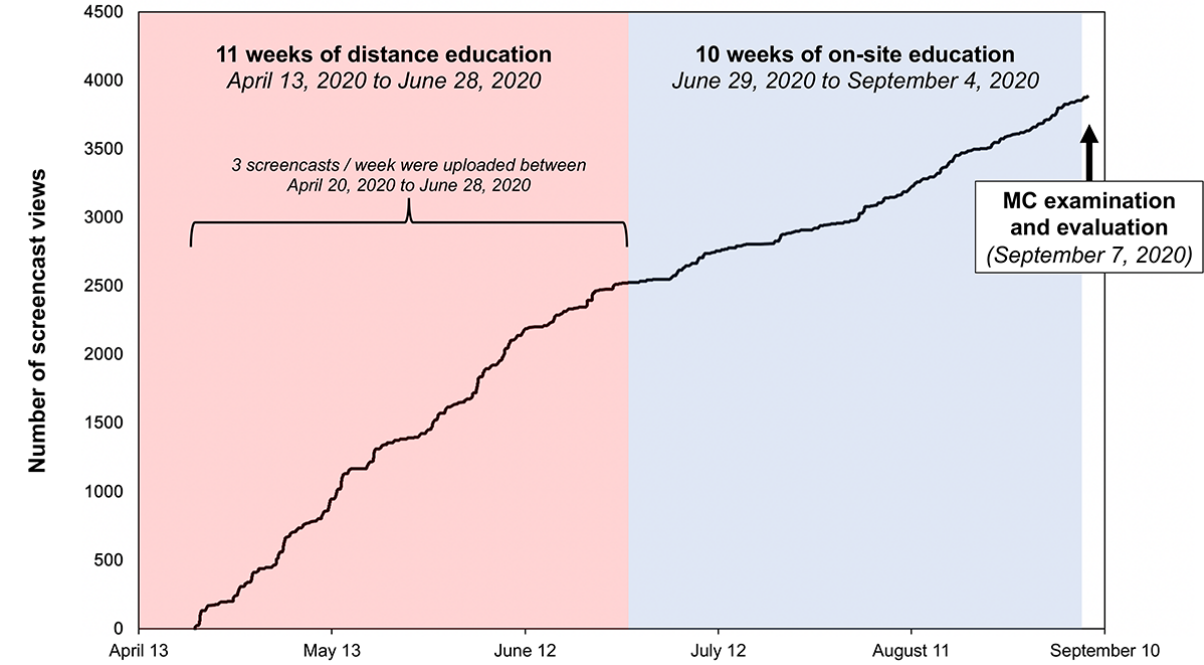
Figure 2. Number of screencasts views over time. Time spans of distance education (theoretical knowledge) and on-site education of physical skills are marked by different colors. All screencasts were uploaded during the distance-education phase. The final examination and evaluation were set after the on-site education phase. MC: